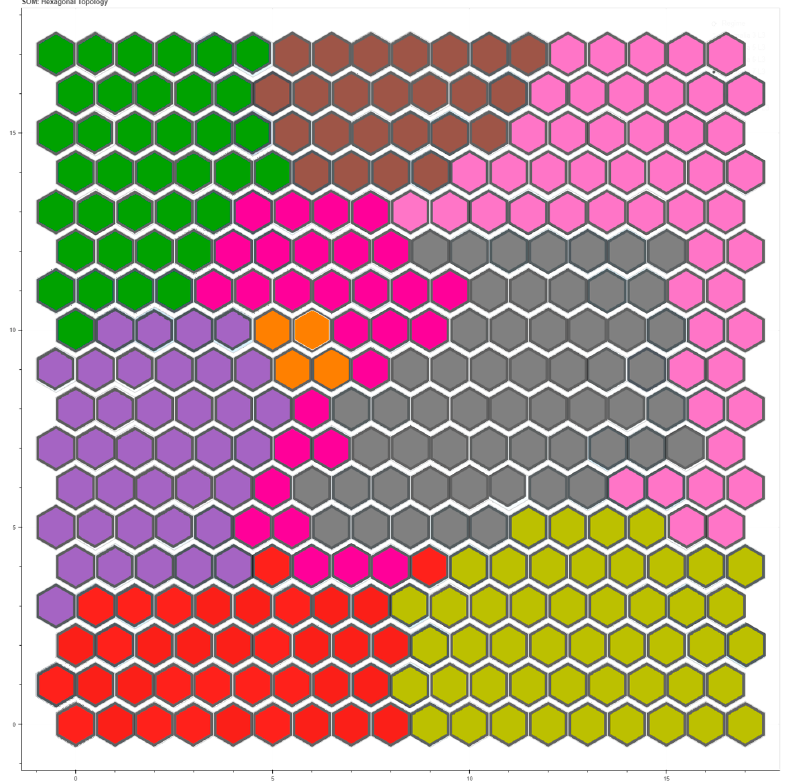
Figure 11. All classes predicted by the SOM algorithm. The color legend can be consulted in Table